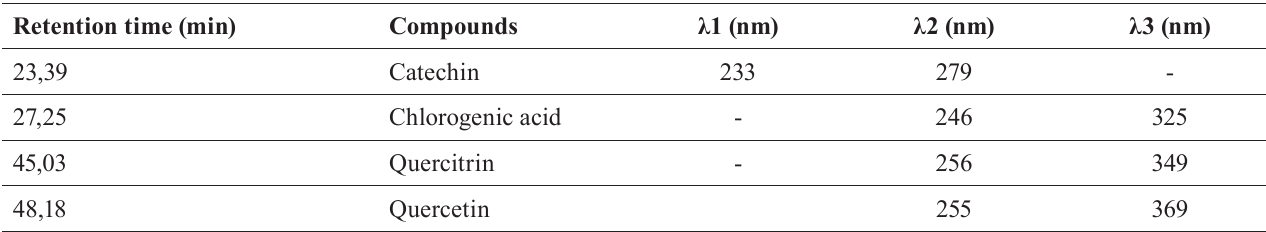
TABLE I - S tandard used for identification of bioactive compounds by high performance liquid chromatography Retention time